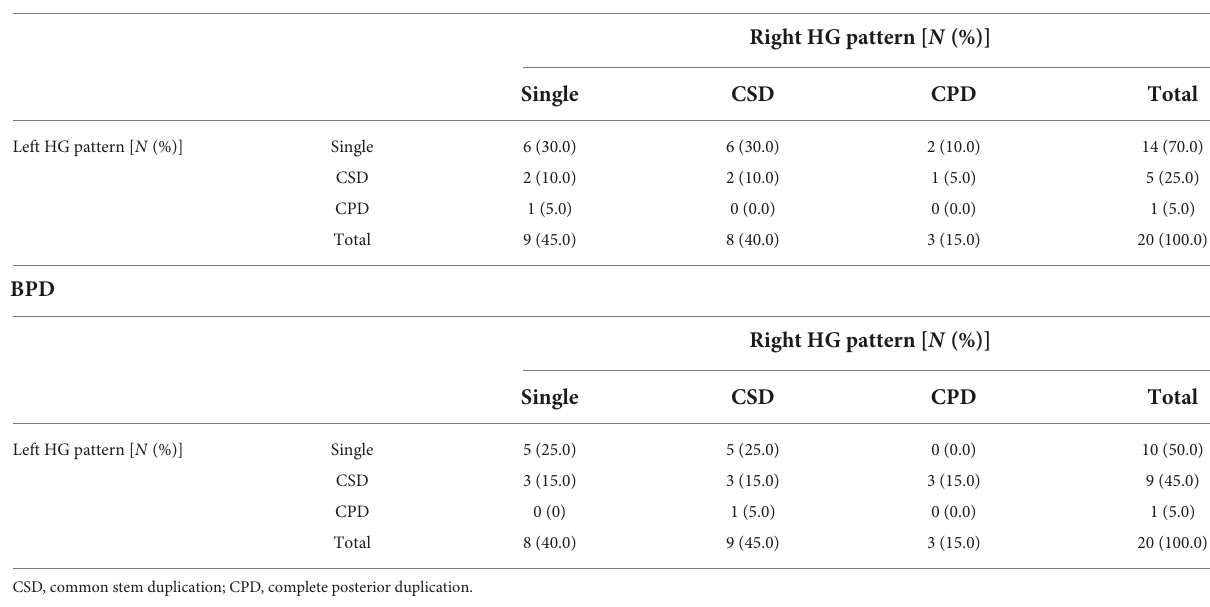
TABLE 2 Gyrification pattern of Heschl’s gyrus (HG) in the study participants. Healthy controls